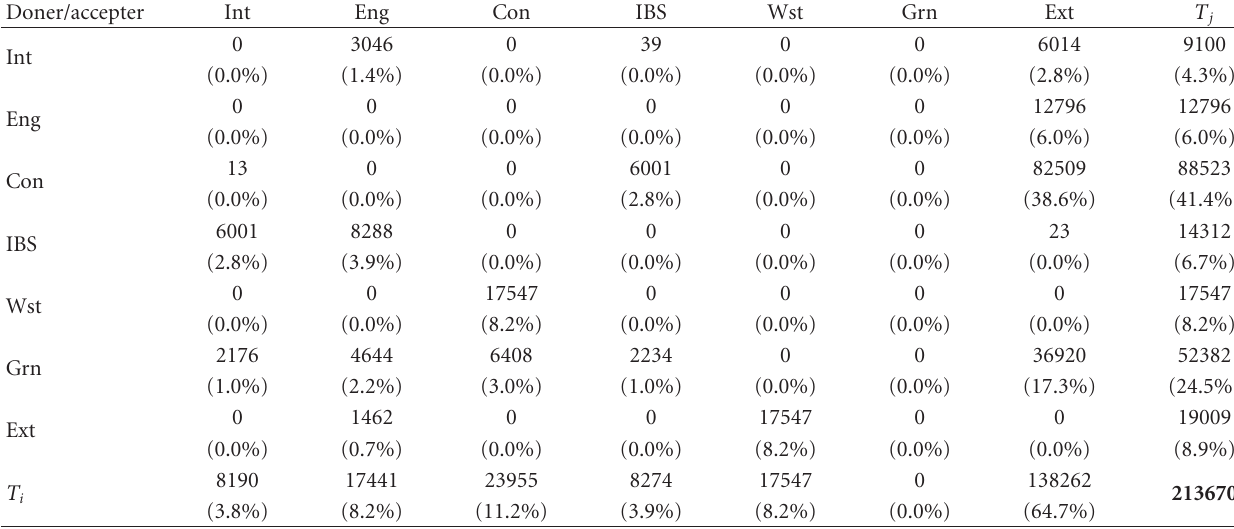
Table 2: Carbon flows within the low-carbon metabolic network of BDA (unit: t CO 2 -eq) a .